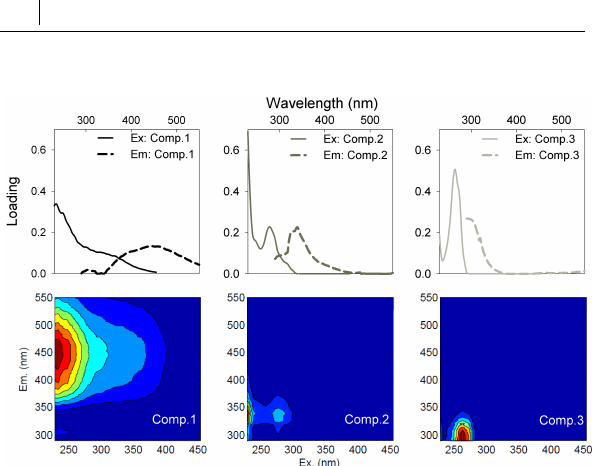
Figure 4. Spectral loadings (upper panels) and fingerprints (lower panels) of the FDOM